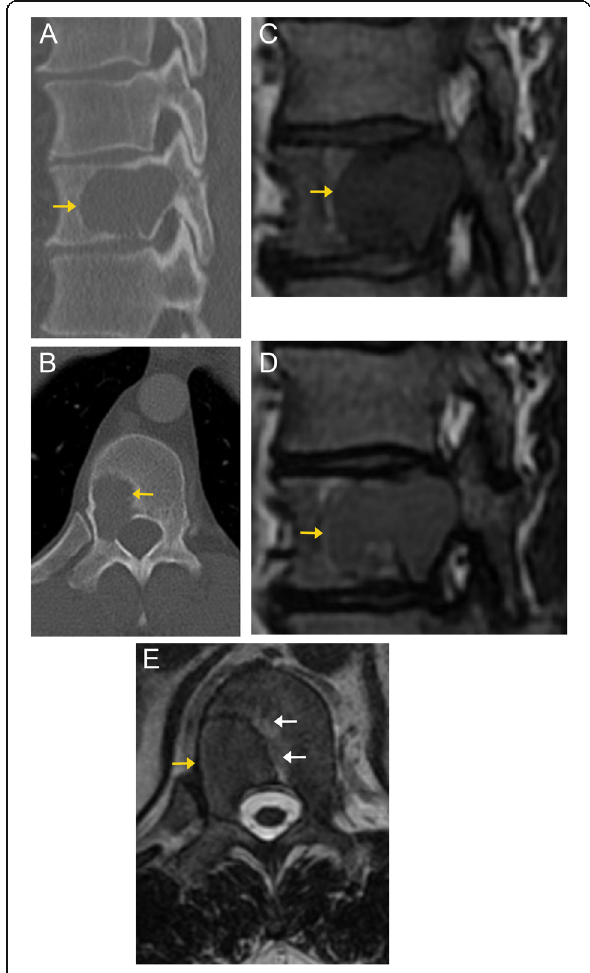
demonstrate a well-defined, expansile lytic lesion involving the right posterolateral aspect of the T10 vertebral body and right pedicle. No discrete sclerotic rim is seen around the lesion margins. Sagittal and axial MR images demonstrate a homogenous, well defined mass (orange arrows) in the posterior aspect of T10, with low signal on T1- ( c , d ) and low to intermediate signal characteristics on T2- ( e ) weighted sequences. A trace amount of increased signal is seen in the adjacent marrow, consistent with mild marrow edema (white arrows)